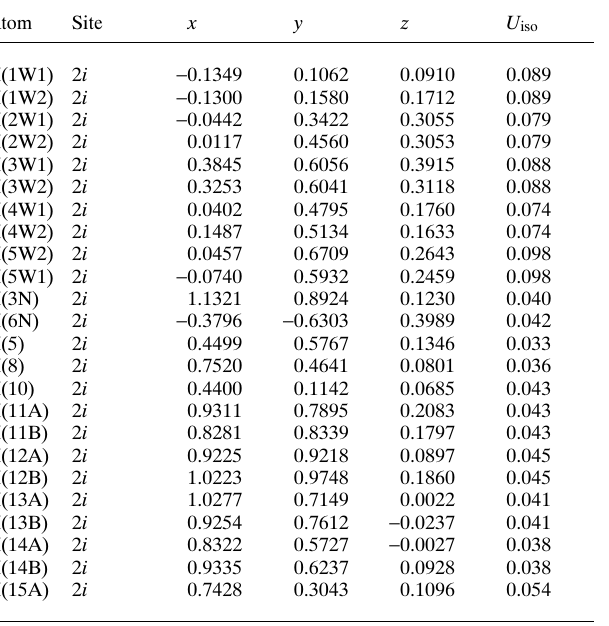
Table 2. Atomic coordinates and displacement parameters (in Å 2 )